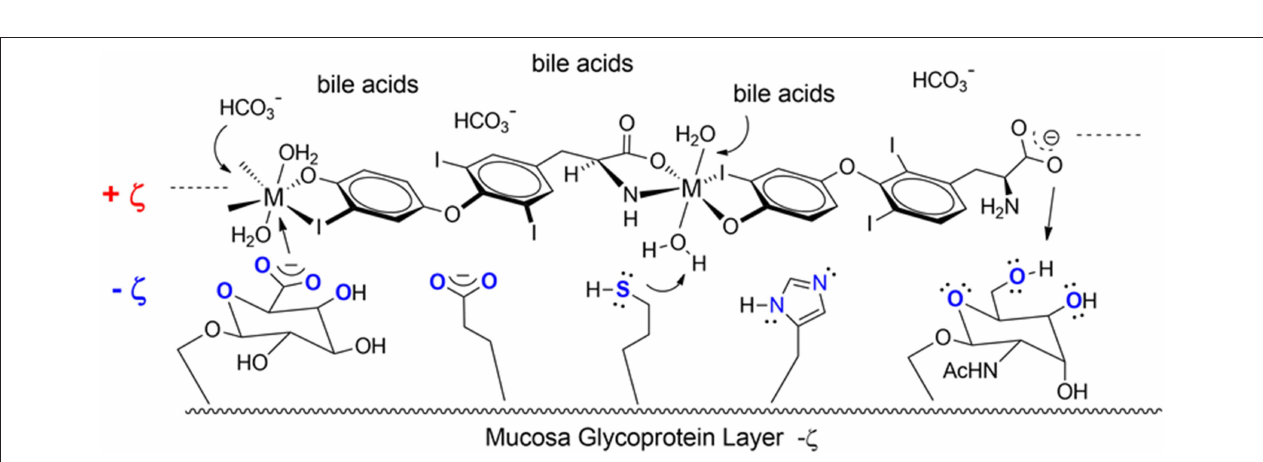
FIGURE 3 | Endogenous ligands in the upper GI tract can affect hydmlysis rate. These include HCI (stomach), bile acids and carbonate buffers (upper intestines).